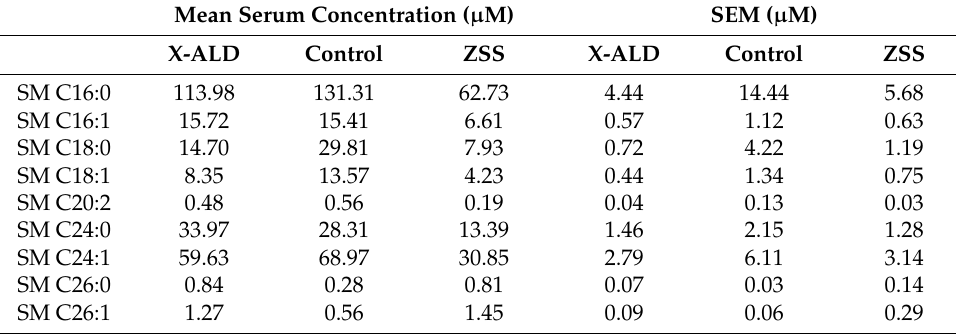
Table A3. VLCFA sphingomyelin species are elevated in serum of X-ALD and ZSS patients, non- VLCFA sphingomyelin species are reduced in ZSS patient compared to controls. Serum from patients analyzed using the Biocrates AbsoluteIDQ p180 kit. Concentrations of sphingomyelin species (SM) in µ M, n = 36 (X-ALD/ABCD1), 28 (Controls), 17 (ZSS/ PEX1 ).